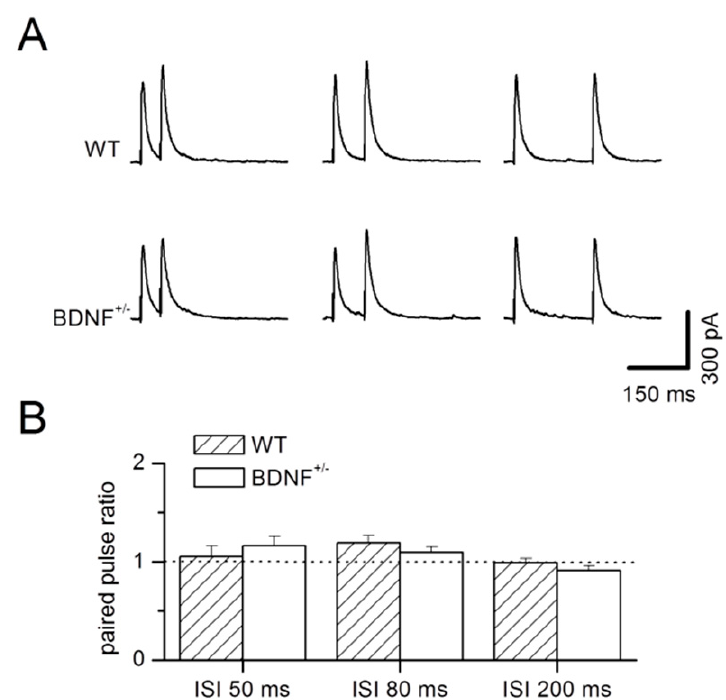
Figure 3. Paired-pulse ratio (PPR) of GABA A mediated evoked IPSCs in LA projection neurons are unaltered in BDNF +/ − mice. ( A ) Typical current traces of evoked paired synaptic stimulations at di ff erent inter-stimulus intervals (ISIs) in a representative WT neuron (top) and BDNF +/ − neuron (bottom), respectively. ( B ) Mean PPRs at di ff erent ISIs (as indicated). Note the unaltered PPR in BDNF +/ − mice compared to WT littermates. WT: n = 10 neurons from 6 animals, BDNF +/ − : n = 10 neurons from 6 animals.